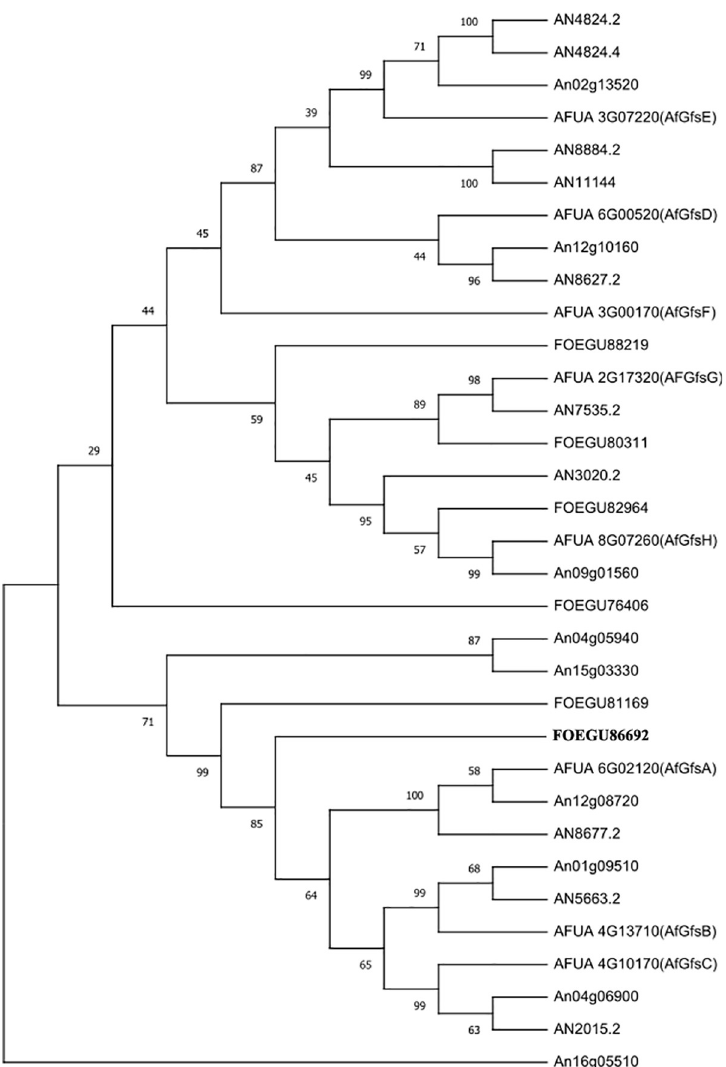
Fig 8. Phylogenetic tree of putative galactofuranosyltransferase from A . nidulans and A . fumigatus . Protein sequences were retrieved from AspGD (https://www.ncbi.nlm.nih.gov/genome/?term=Aspergillus+fumigatus) and DNAman2.0 was used to make the homology tree. % of homology between the proteins is indicated.